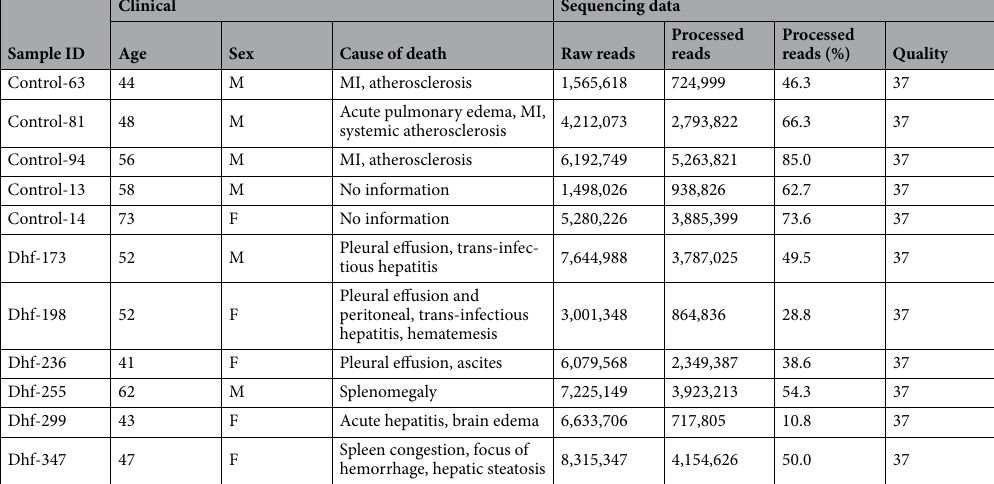
Table 1. Clinical data and sequencing results per sample. MI: acute myocardial infarction; Dhf: dengue hemorrhagic